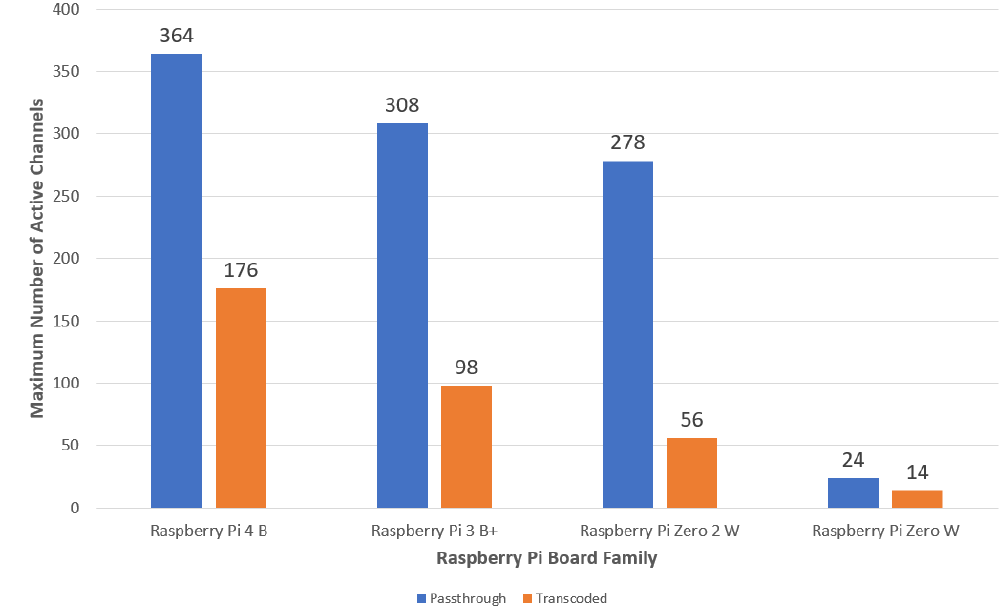
Figure 11. Contrasting the maximum number of simultaneous active channels that different Rasp- berry Pi board families can gracefully